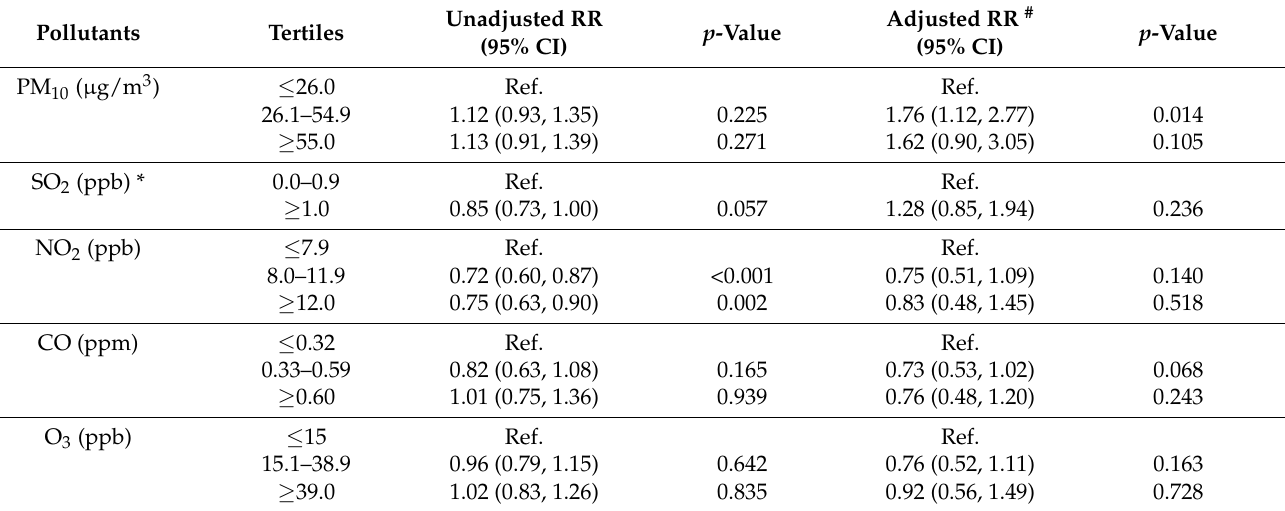
Table 8. Relative risk for APE associated with exposure to elevated air